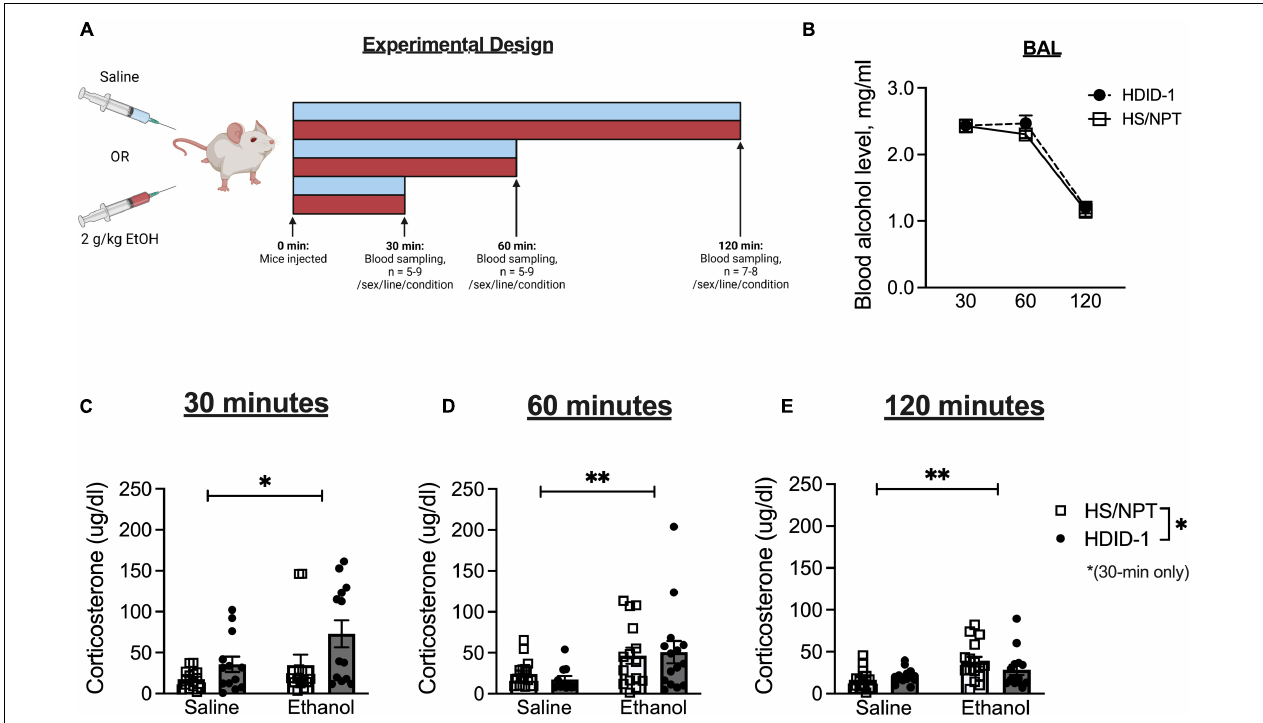
FIGURE 1 | HDID-1 mice exhibit greater stimulated corticosterone response than HS/NPT founders. (A) Separate groups of HDID-1 and HS/NPT mice were given either a 2 g/kg ethanol injection or an equivalent volume of saline and blood samples were collected at either 30, 60, or 120 min after injections to measure corticosterone levels. (B) In mice that received ethanol injections, BALs were similar across time in the two genotypes. (C) At 30-min post-injection there was a significant effect of condition (ethanol > saline), genotype (HDID-1 > HS/NPT), and sex (females > males, data collapsed across sex in figure for ease of viewing). (D,E) At 60- and 120-min post-injection, the condition effect remained, but the sex and genotype effects were no longer evident. These data suggest that HDID-1 mice exhibit a greater stimulated response to injection. Means ± SE shown. ∗ p < 0.05; ∗∗ p < 0.01.